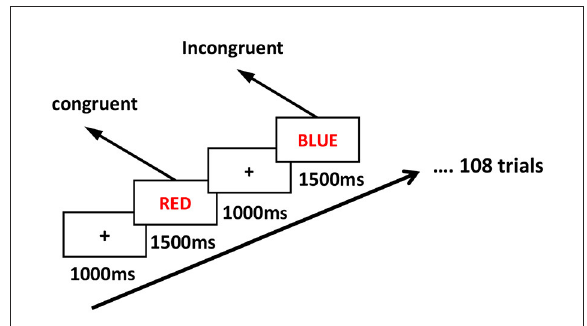
FIGURE1 The Stroop task paradigm. The entire Stroop task consists of a practice task consisting of 15 trials and a formal task composed of 108 trials (36 incongruent, 72 congruent).